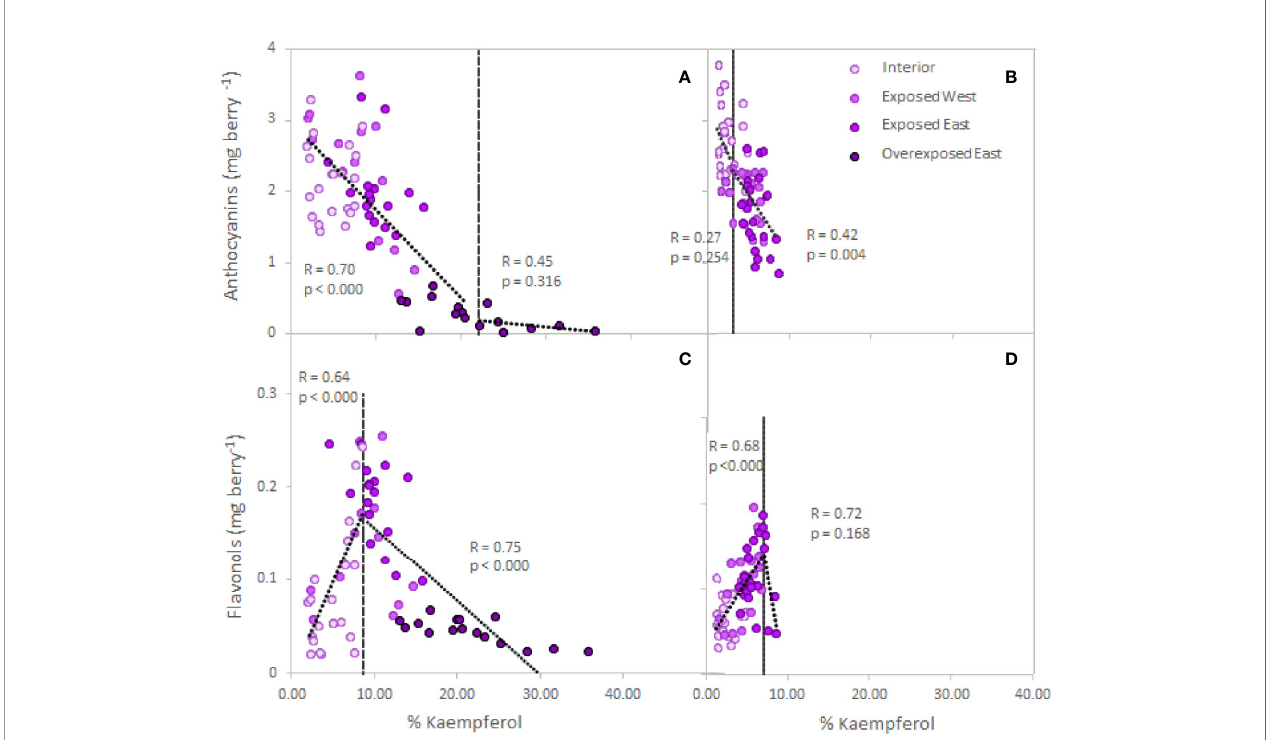
FIGURE 2 | Relationship between grape skin anthocyanin (A, B) and fl avonol (C, D) content (mg per berry) and increasing exposure (% of kaempferol, Mart ı ́ nez- Lüscher et al., 2019) in Cabernet Sauvignon (A, C) and Petit Verdot (B, D) single berries collected from the cluster interior (Exp − ), exposed West (Exp+ Deg − ), exposed East (Exp+ Deg+) and overexposed East (Exp+ Deg++). Grey dashed lines are the breaking points determined through segmented